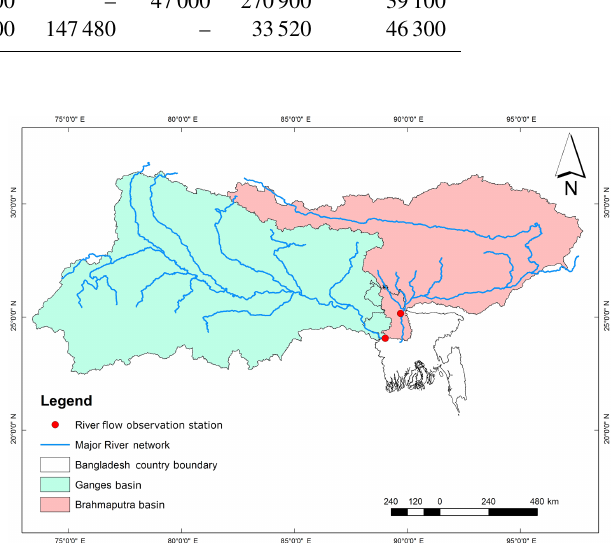
Figure 1. Ganges–Brahmaputra Basin map with respect to